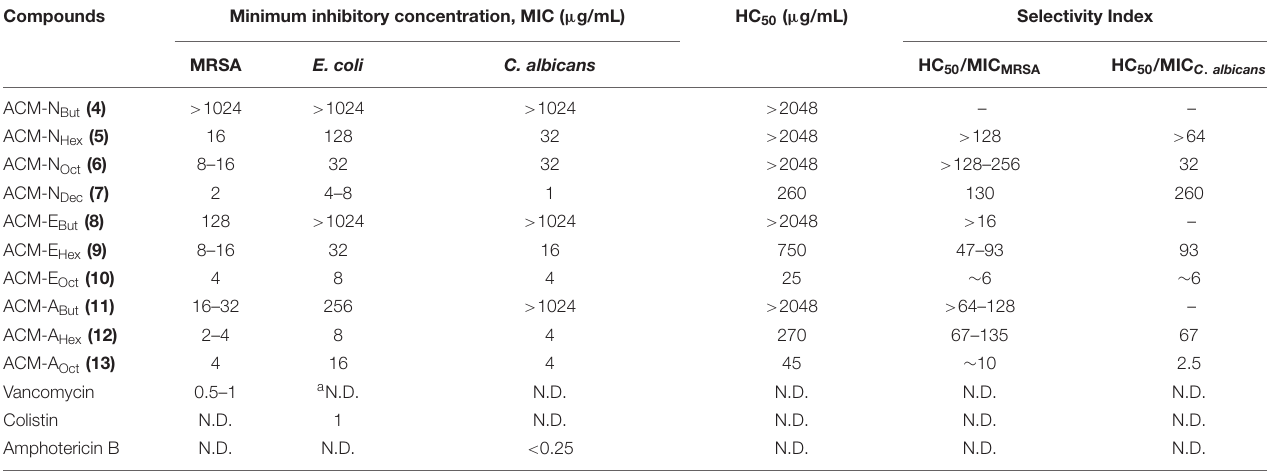
TABLE 1 | Antimicrobial and hemolytic activity of the amphiphilic cationic macromolecules (ACMs). Compounds Minimum inhibitory concentration, MIC ( µ g/mL) HC 50 ( µ g/mL)